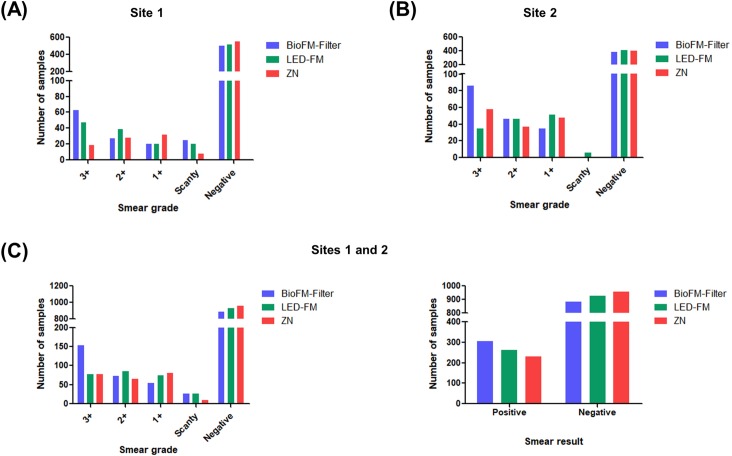
Comparison of smear grade status by ‘BioFM-Filter’ vs. Direct smear microscopy (LED-FM and ZN).(A) At site 1, NITRD (n = 550); (B) At site 2, TB hospital, Ambala (n = 640); (C) combined performance at both the sites (n = 1190). Left panel: smear grade status; right panel: smear results.